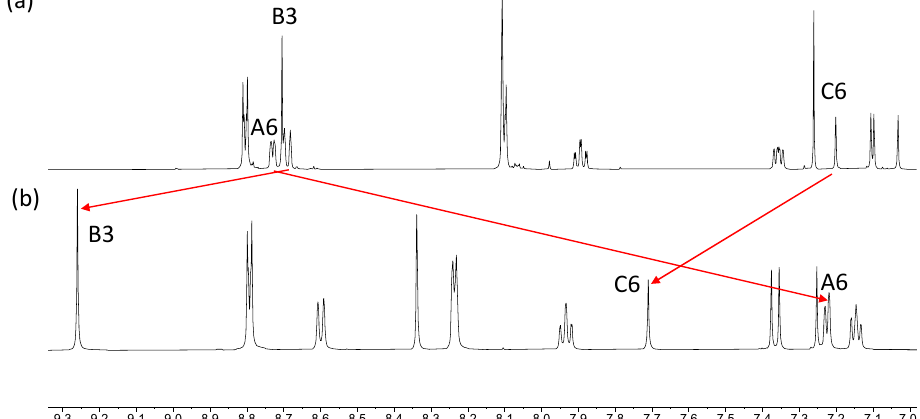
Figure 7. Comparison of the aromatic regions of the 1 H NMR spectra (500 MHz, 298 K) for ( a ) com- pound 6 in CDCl 3 , and ( b ) [Fe( 6 ) 2 ][BF 4 ] 2 in CD 3 CN. Differences in solubilities required the use of different solvents.